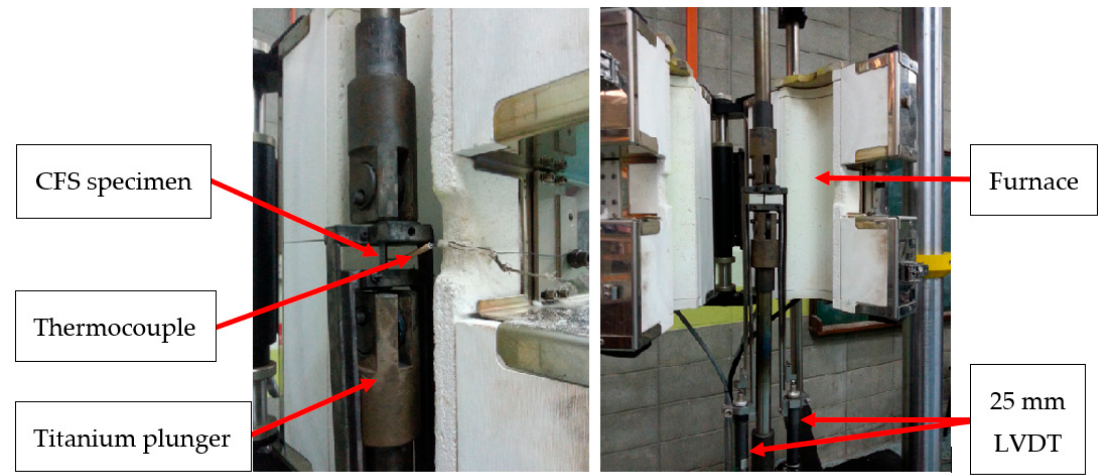
Figure 2. Testing set-up of high temperature tensile test.